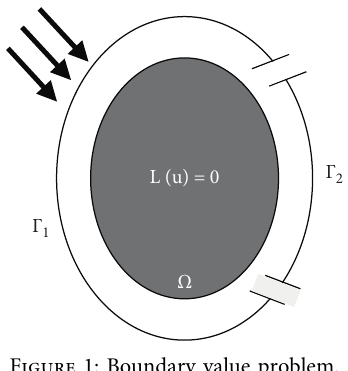
Figure 1: Boundary value